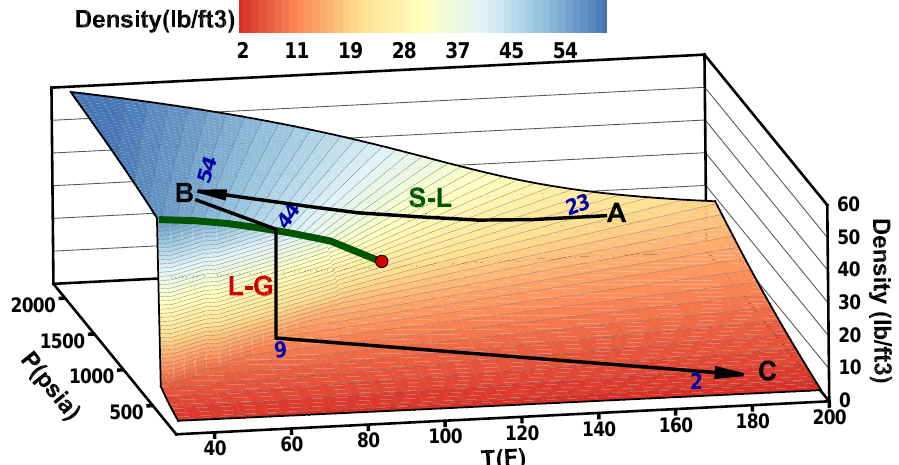
Figure 3. CO 2 density (lb/ft 3 ) versus temperature and pressure shown on a 3D plot including the CO 2 phase stages A, B, and C and their connecting pathlines.